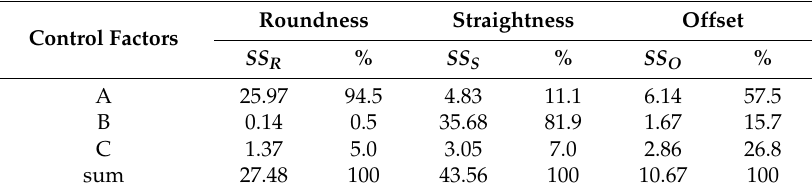
Table 8. Contributions of the parameters.